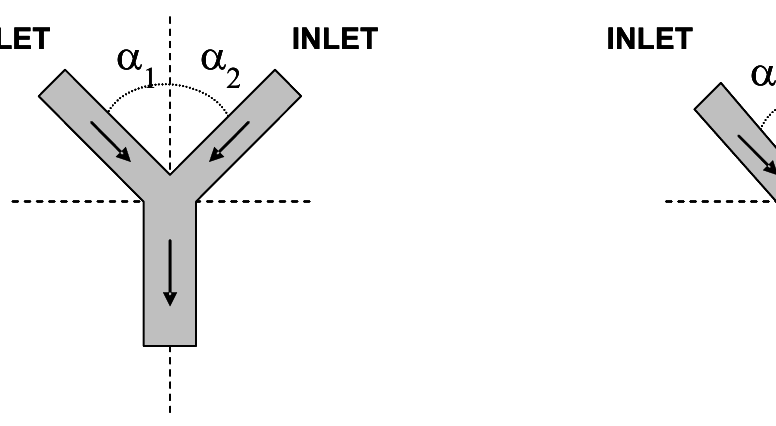
Figure 2. Different ψ - and Y-flow microchannel inlet geometries in multiphase flows. Arrow = flow direction; α - variable that controls the inlet angle responsible for different flow characteristics. In T-shaped inlet, α